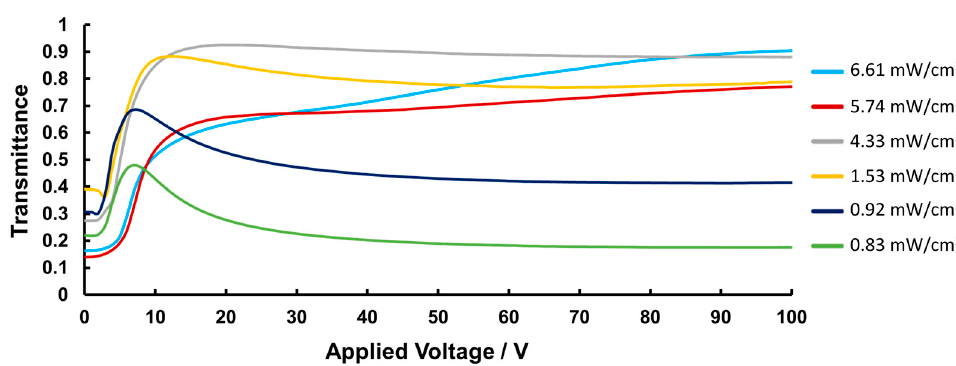
Figure 10. Corresponding T-V curves of incident non-polarized probe beam at normal incidence for five PDLC cells after UV curing with intensities of 6.61, 5.74, 4.33, 1.53, 0.92, and 0.83 mW/cm 2 .